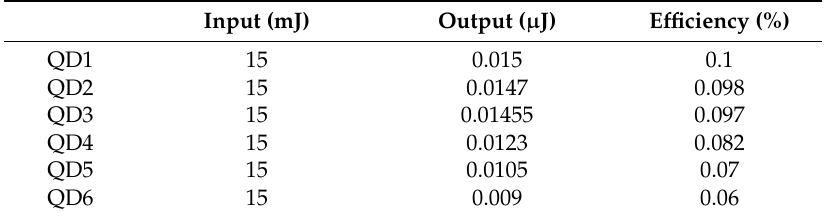
Table 2. Measured input, output and efficiency.